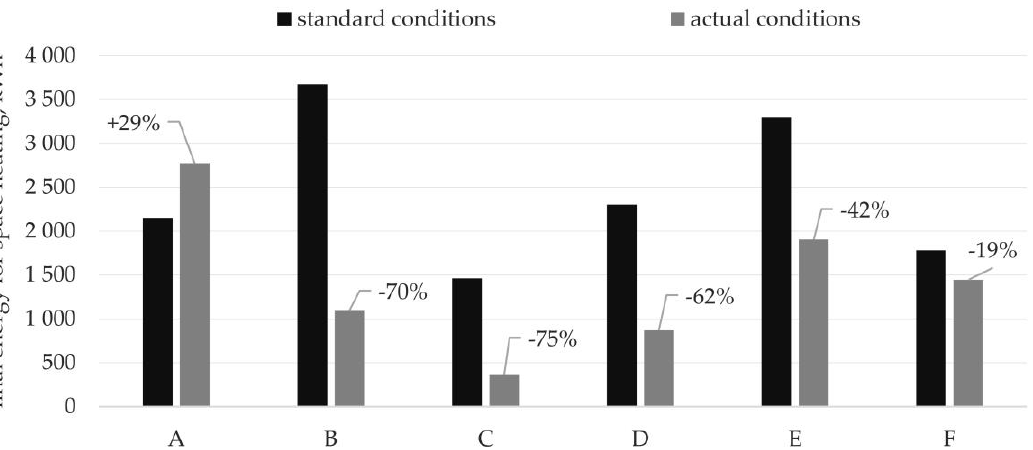
Figure 3. Actual and standard final energy consumption for space heating for time period from 14 January to 9 March 2020 showing the energy performance gap for space heating ( EPG h ).